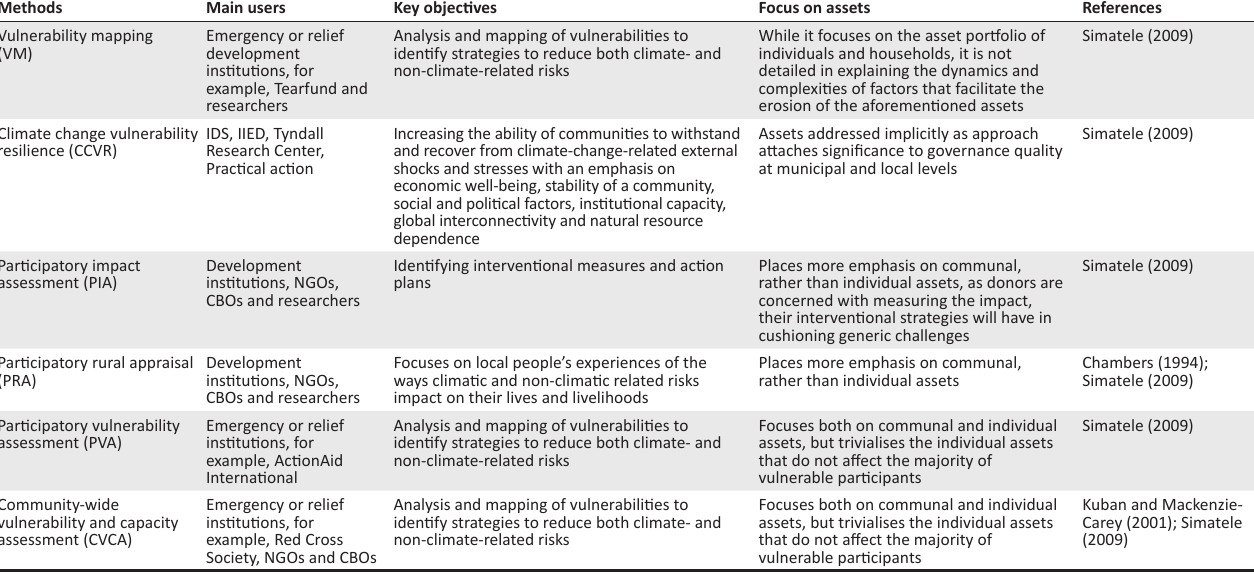
TABLE 1: Participatory methodologies employed in conducting vulnerability